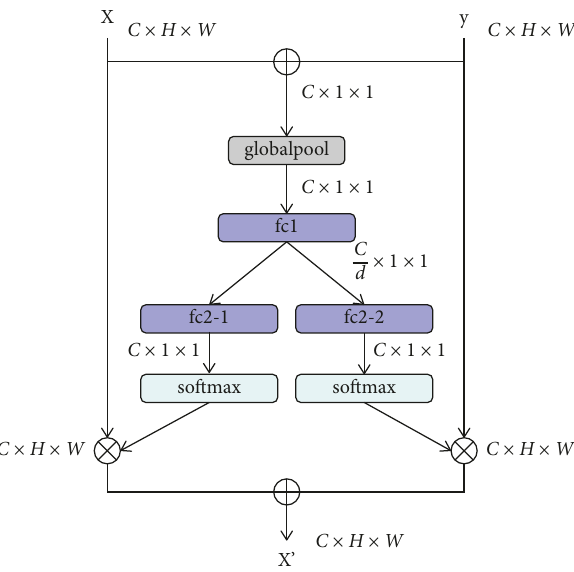
Figure 6: SKNet fusion module.